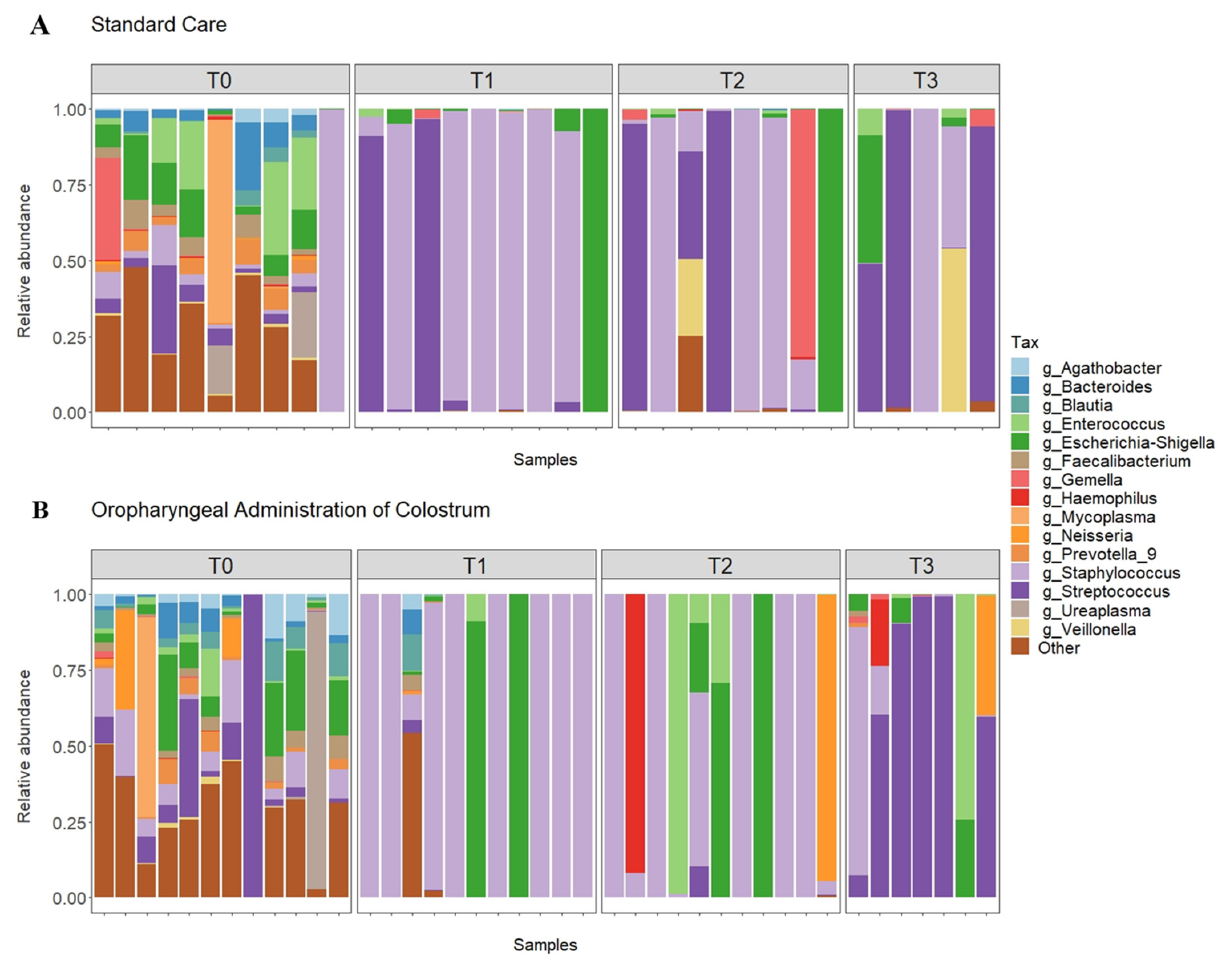
Figure 1. Relative abundance of top 15 genera in all samples from the SC ( A ) and OAC ( B ) groups over time. Legend: OAC (Oropharyngeal Administration of Colostrum); SC (Standard Care); T0 (first day of life), T1 (7 days after birth), Time 2 (14 days after birth), Time 3 (21 days after birth).